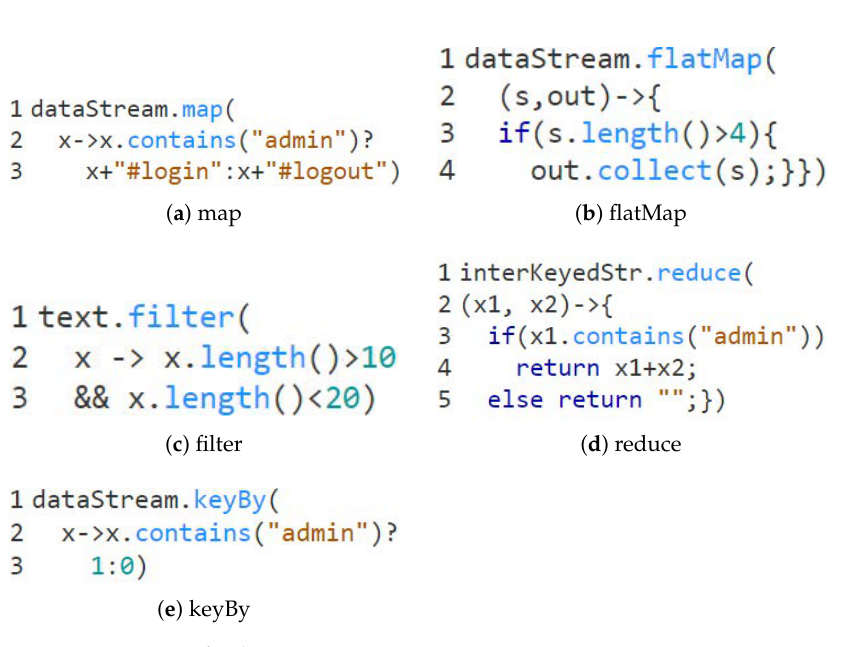
Figure 7. Snippets of Subject